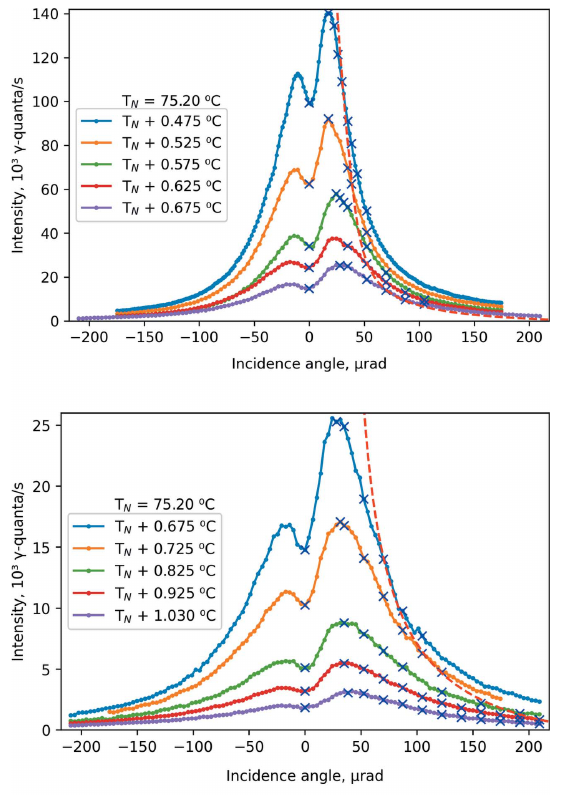
Figure 2 The evolution of rocking curves with temperature for lowest (top panel) and highest (bottom panel) temperatures. The incidence angle (cid:4) is given as the deviation from the Bragg angle determined by accounting for the shift due to refraction of the incident beam at the entrance into the crystal. Blue crosses indicate the angular positions where the Mo¨ssbauer spectra were measured. The red dashed line shows the optimal conditions for SMS operation (see text).